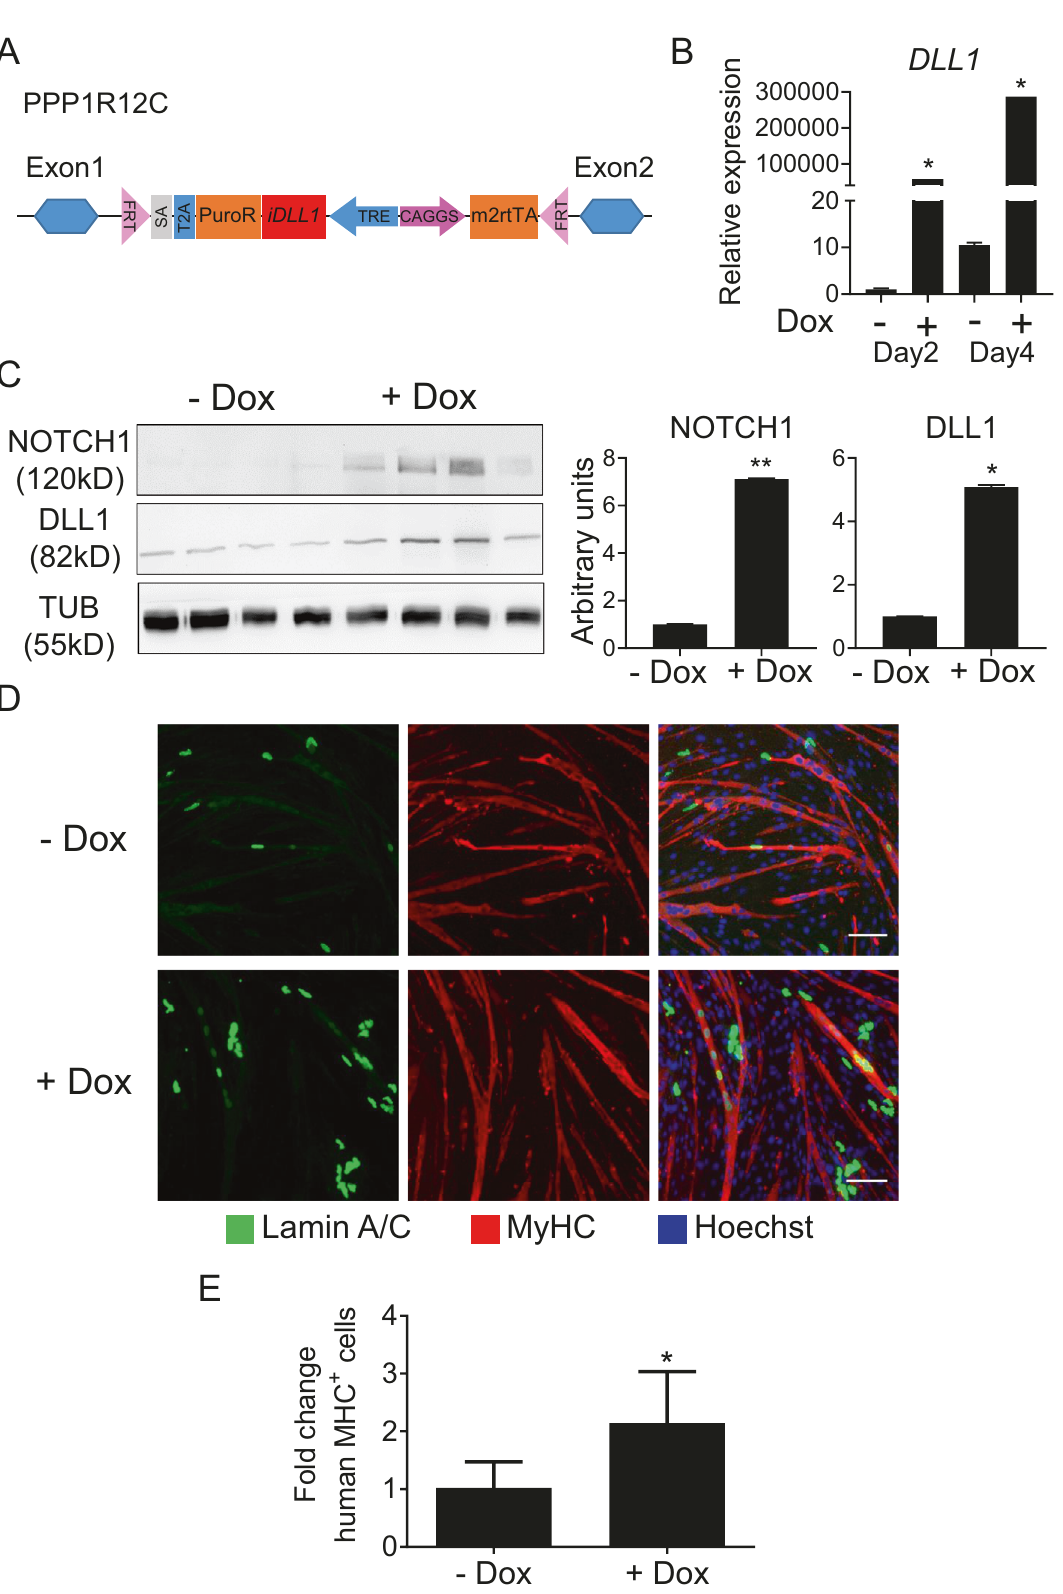
Fig. 4 DLL1 overexpression improves the myogenic propensity of mesodermal progenitors. A Schematic overview of the doxycycline (dox)-inducible DLL1 construct fl ipped into an embryonic stem cell (ESC) master line. B Quantitative PCR for DLL1 after exposure of the generated ESC line to dox for two or four days. C Western blot for DLL1 and NOTCH1 after exposure of the generated ESC line to dox for four days. Tubulin (TUB) was used as a housekeeping protein. Quanti fi cation graph is on the right. D Immuno fl uorescence analysis of lamin A/C- positive mesodermal progenitors, with or without dox, (green) in co-culture with C2C12 myoblasts ( n = 3). Scale bars: 100 µm. * P < 0.05. Cell Death and Disease (2021)